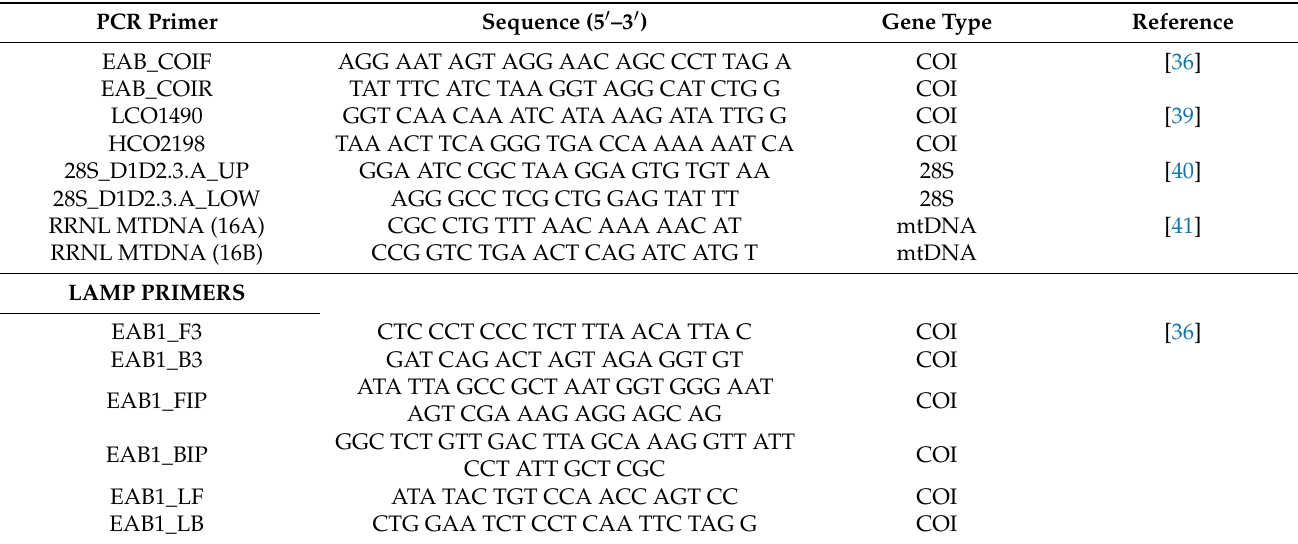
Table 2. General and specific PCR and LAMP primers used to amplify and confirm insect DNA. PCR Primer Sequence (5 (cid:48) –3 (cid:48) ) Gene